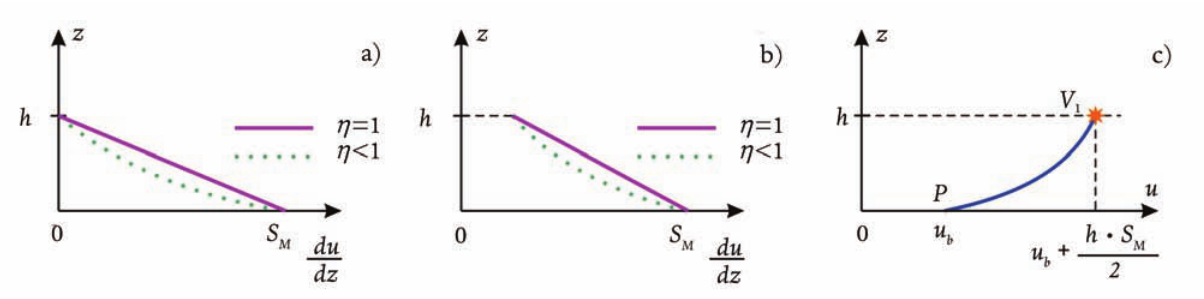
Figure 5. (a) Shear rate for a macro-viscous flow (cyclamen curve) and a shear-thinning flow (dotted green curve). Shear rate is null at the top of the flow and it has a peak s at z = 0. (b) The same as (a), but the shear rate differs from zero at the flow upper boundary. (c) Velocity profile of the macro-viscous M flow of (a). The velocity profile is a parabola with vertex in V . At point P , the parabola has a tangent = s M 1